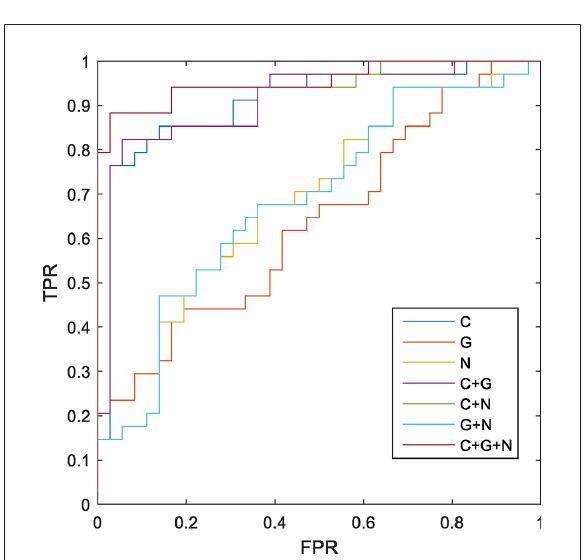
FIGURE4 Receiveroperatingcharacteristic(ROC)ofclassificationbasedon different morphological connectome features. C, connection; G, global metrics; N, nodal metrics; FPR, false-positive rate; TPR, true-positive